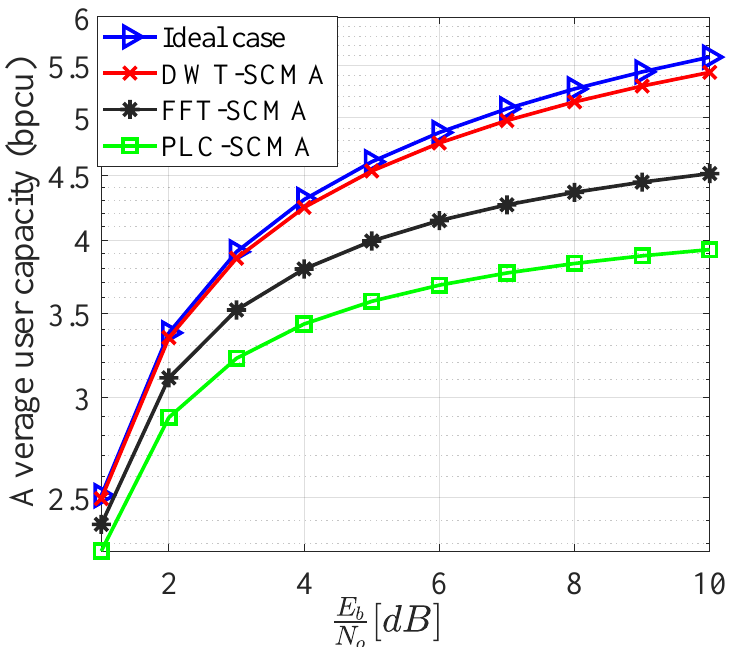
Figure 9. Average user capacity vs. E b / N o , a comparative analysis among PLC-SCMA and FFT/DWT- SCMA.